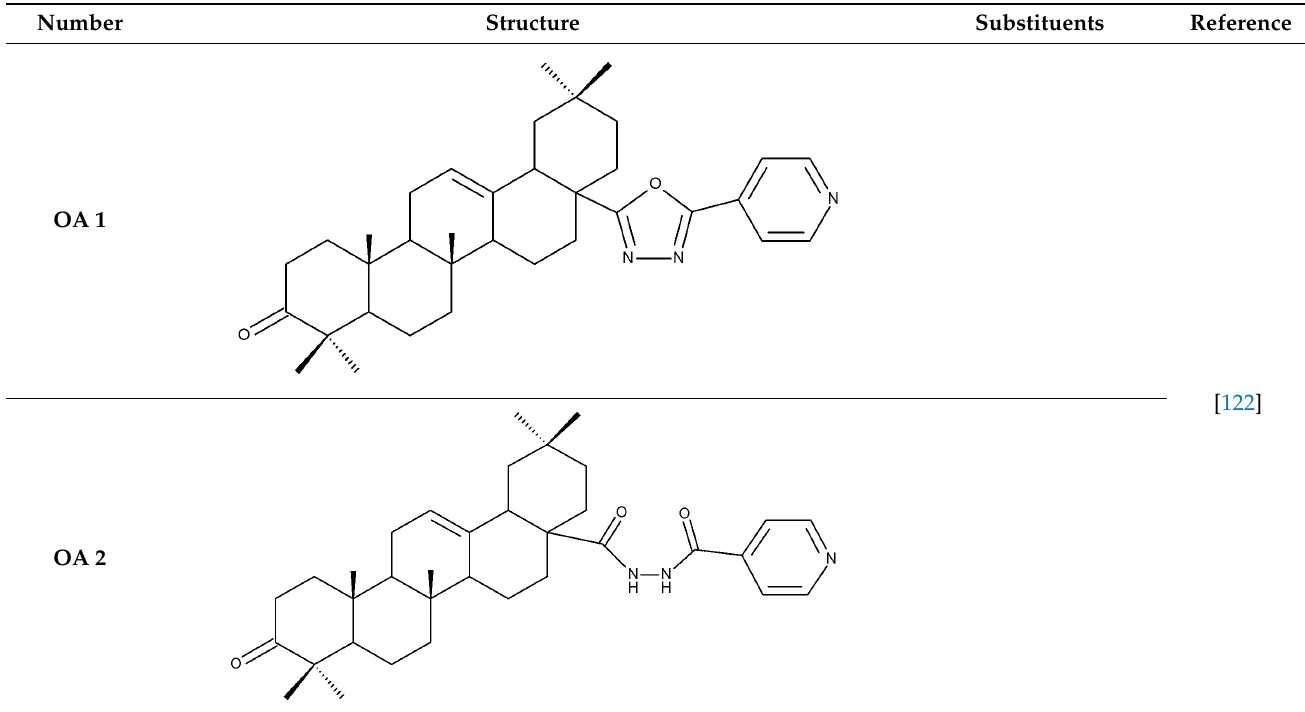
Table 7. The chemical structures of oleanolic acid derivatives.